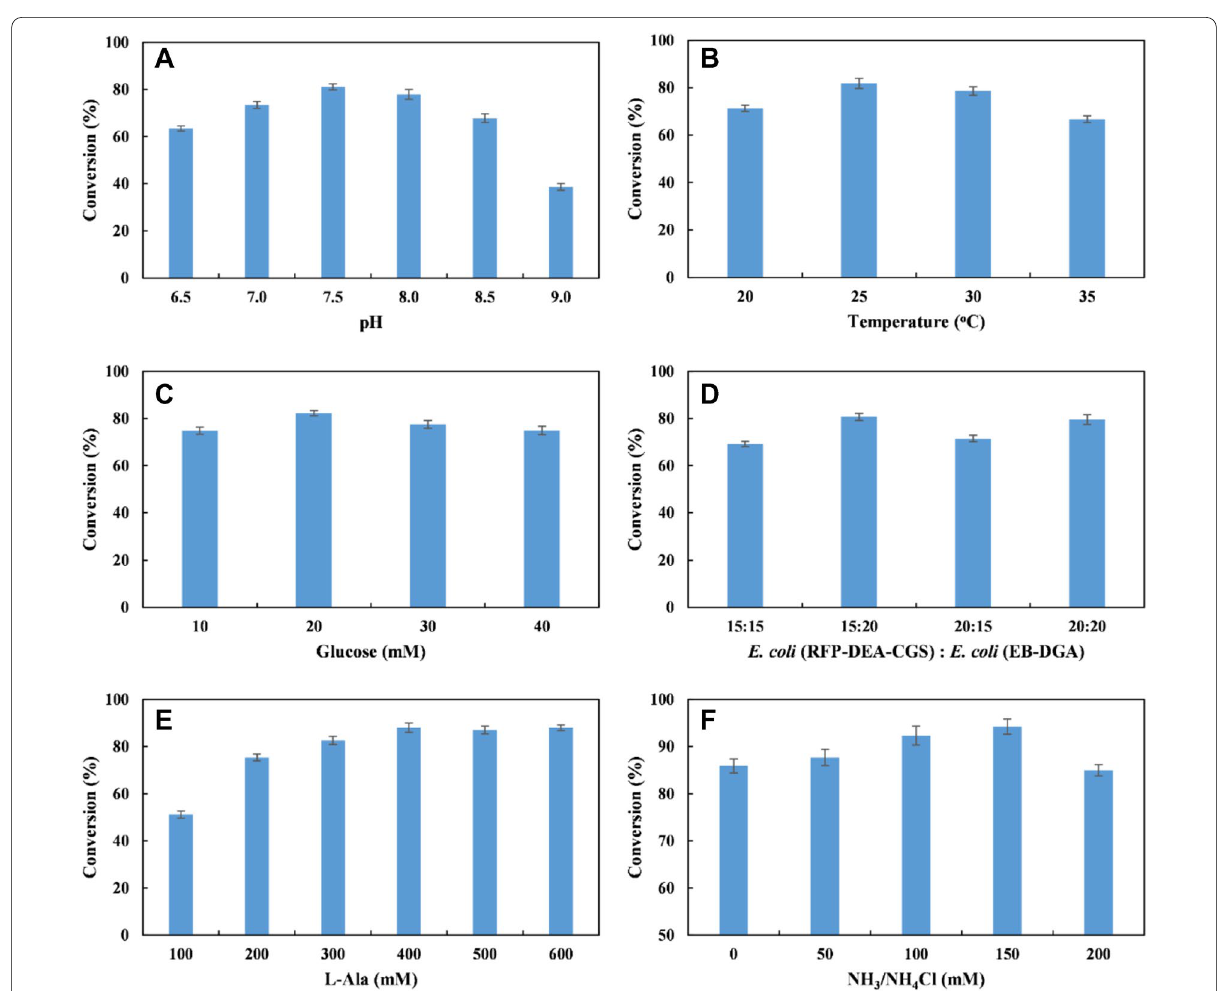
Fig. 6 Reaction condition optimization for conversion of L-PA 1 (20 mM) to ( R )-7 by the designed E. coli (RFP-DEA-CGS) and E. coli (EB-DGA) consortium. A Effect of different pH on the conversion of ( R )- 7 ; B effect of different temperature on the conversion of ( R )- 7 ; C effect of glucose concentration on the conversion of ( R )- 7 ; D effect of different cell density of E. coli (RFP-DEA-CGS) and E. coli (MVTA) on the conversion of ( R )- 7 ; E effect of L-Ala concentration on the conversion of ( R )- 7 ; F: effect of NH 3 /NH 4 Cl concentration on the conversion of ( R )-